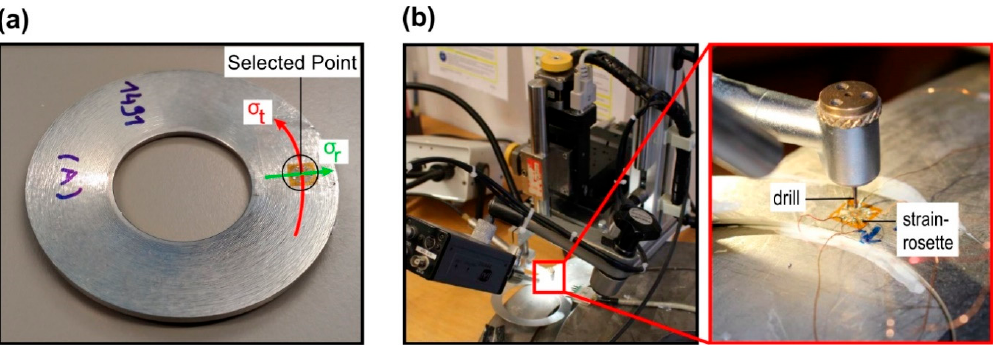
Figure 3. ( a ) Selected point for the measurement of the residual stresses, and ( b ) experimental set-up of the hole drilling method.